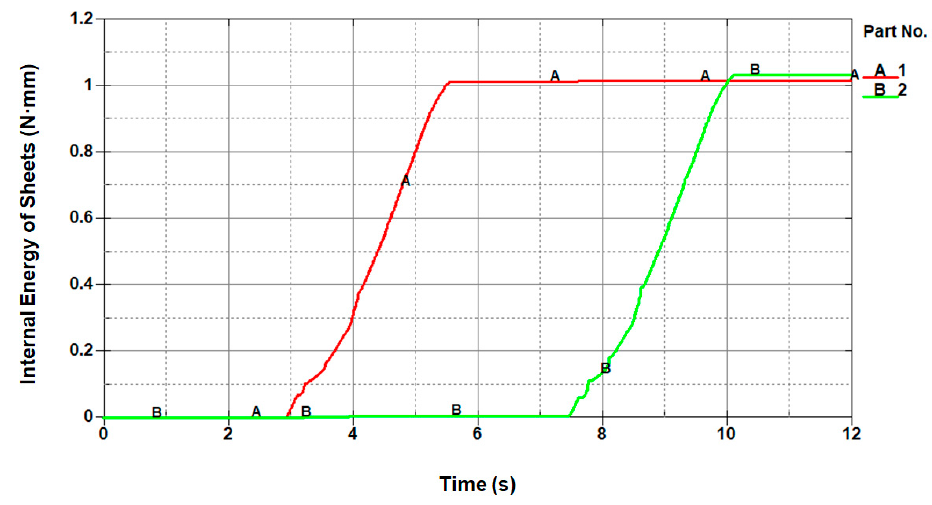
Figure 12. Internal energy for separated sheets being cut versus time: ( A 1 )—in the first sheet, ( B 2 )—in the second sheet.